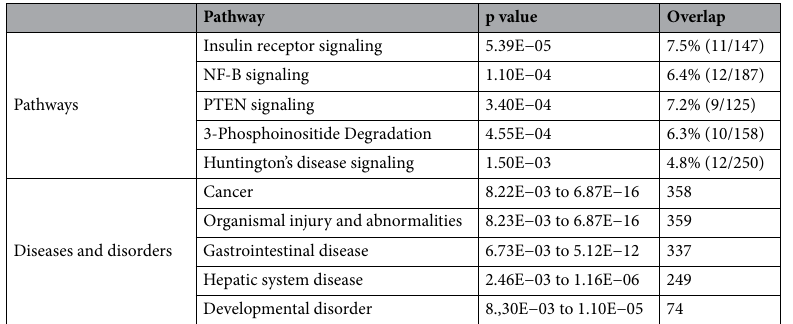
Table 2. Top significant pathways and disorders (FDR < 0.05) for target genes of differentially expressed miRNAs.